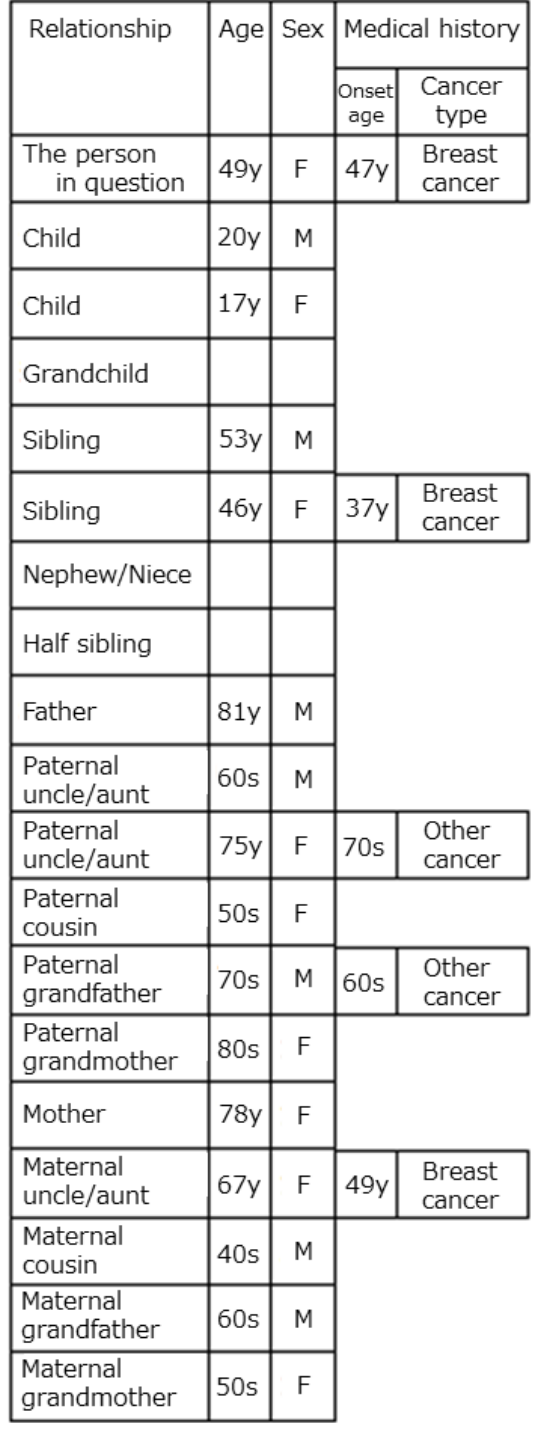
Figure 7. Snapshot of the family history obtained as a result of the preliminary screening by the chatbot for scenario 1. The results were originally presented in Japanese and translated into English. The screen of the terminal presents one of the results. F: female; M: male: y: years of